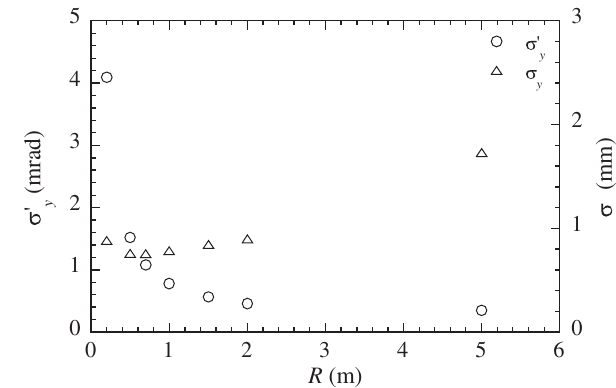
FIG. 1. Vertical angular distribution of radiation for the experimental conditions in Ref. [20] and the reflecting plane (011). Electron energy 255 MeV; diamond crystal thickness, 50 μ m; (022) reflection order; observation angle Θ